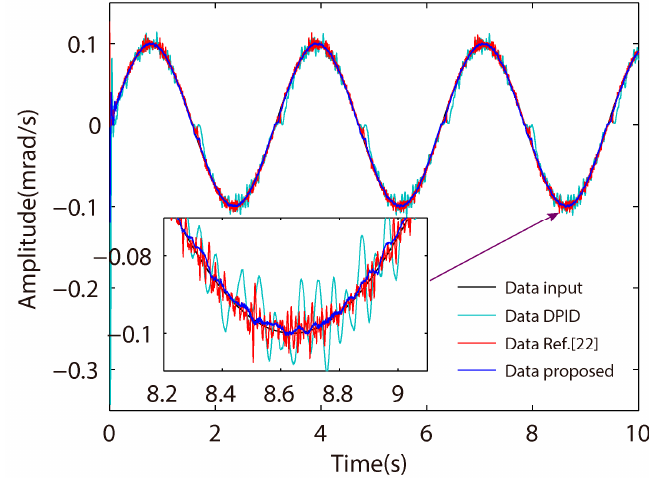
Figure 10. Velocity sinusoidal guidance contrast curve.